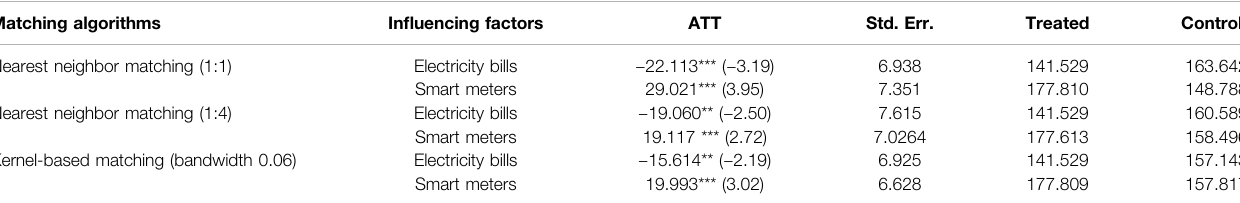
TABLE 8 | Average treatment effects of different matching algorithms. Matching algorithms In fl uencing factors ATT Std. Err. Treated Controls Nearest neighbor matching